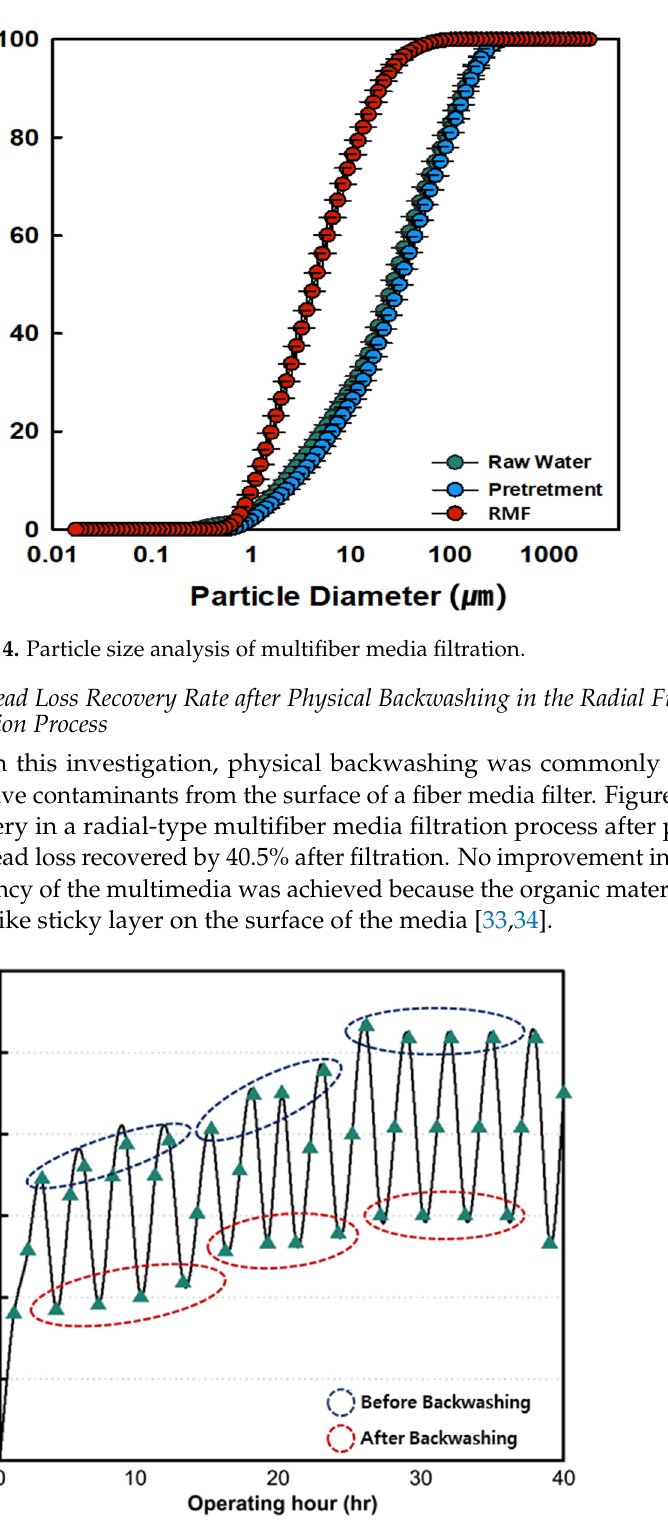
Figure 5. Head loss recovery in radial-type multifiber media filtration process after physical back- washing every 2.5 h.